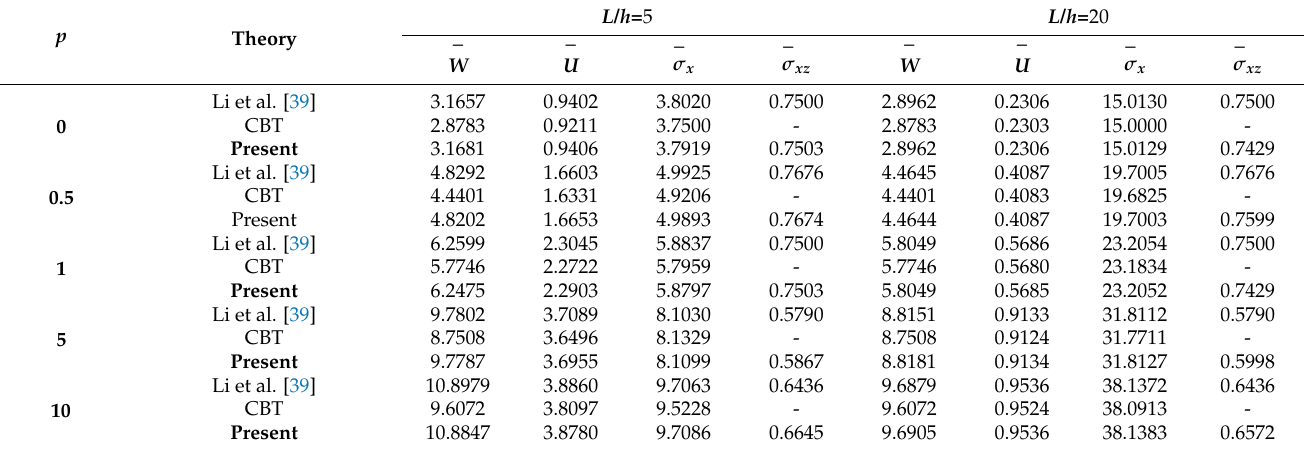
Table 2. Comparison of non-dimensional transverseand axial displacements, axial and shear stresses of S-S FG beam for various material indexes and slenderness ratio ( L / h